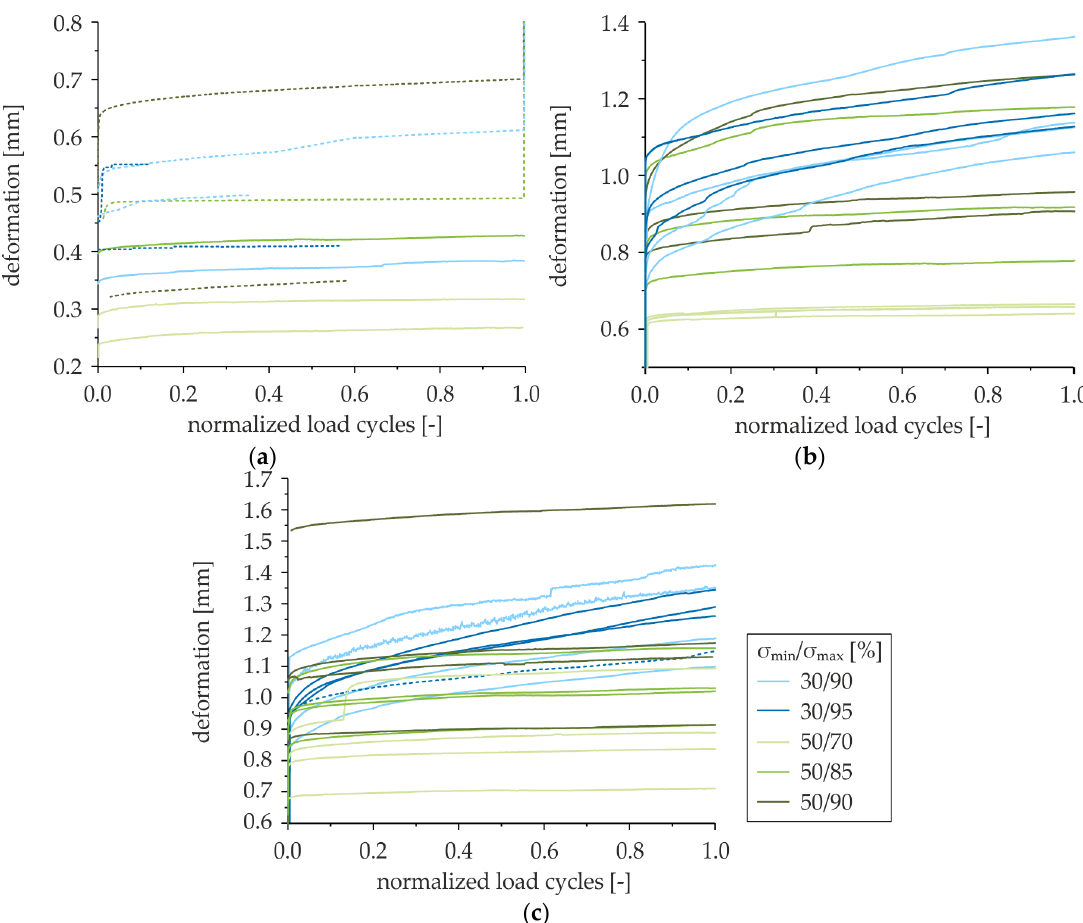
Figure A4. Comparison of normalized cyclic creep curves depending on the load level: ( a ) anchorage length = 1 a ; ( b ) anchorage length = 2 a ; ( c ) anchorage length = 4 a .